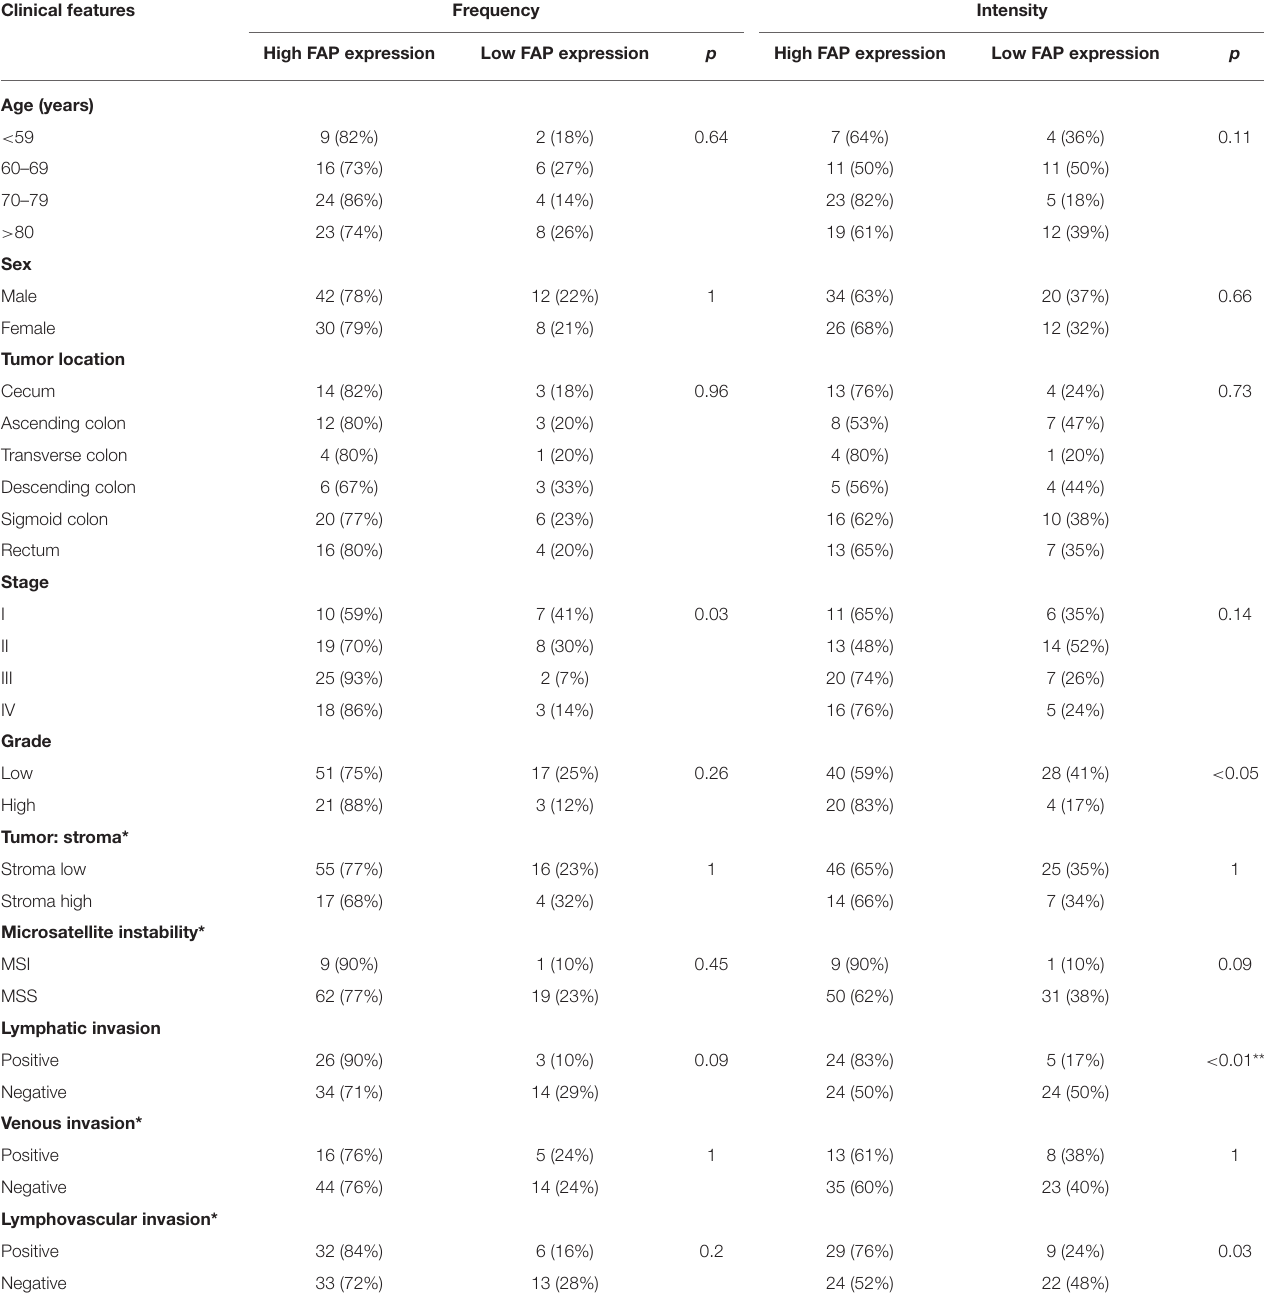
TABLE 1 | Association between FAP protein expression and clinicopathological features in the TMA cohort. Clinical